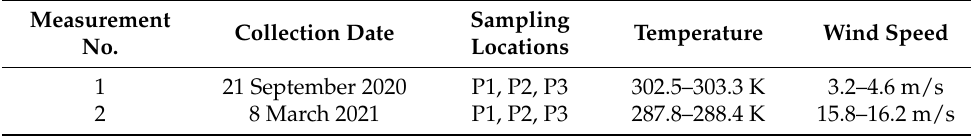
Table 1. Collection parameters of each measurement in experimental